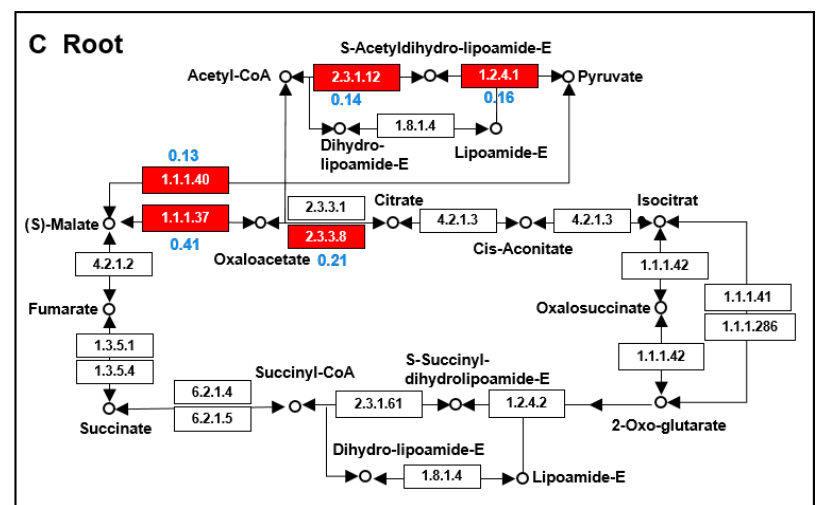
Figure 5. Mapping of proteins related to the TCA cycle in three organs from Morus . The TCA cycle pathways were identified by the mapping of the identified proteins from the leaf ( A ), branch ( B ), and root ( C ) using the KEGG database. Enzymes in red represent identified proteins, and the blue number represents the protein abundance. The EC number for the following proteins are 1.1.1.37,